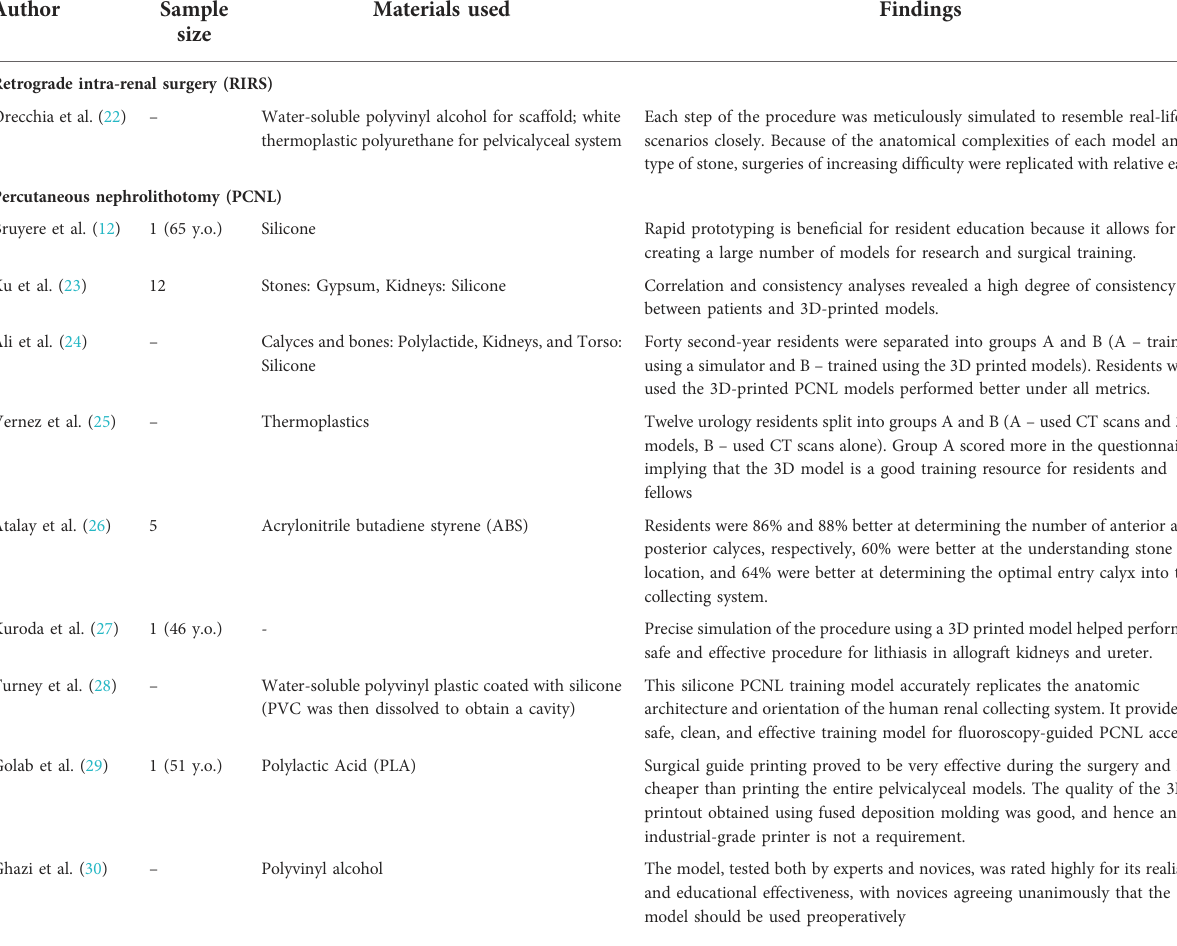
TABLE 1 Summary of recent studies related to three-dimensional (3D) printing in